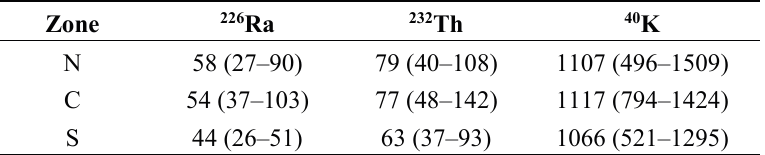
Table 2. Average and range of the activity concentrations (Bq·kg − 1 ) of 226 Ra, 232 Th and 40 K found in the soils of Chihuahua City.